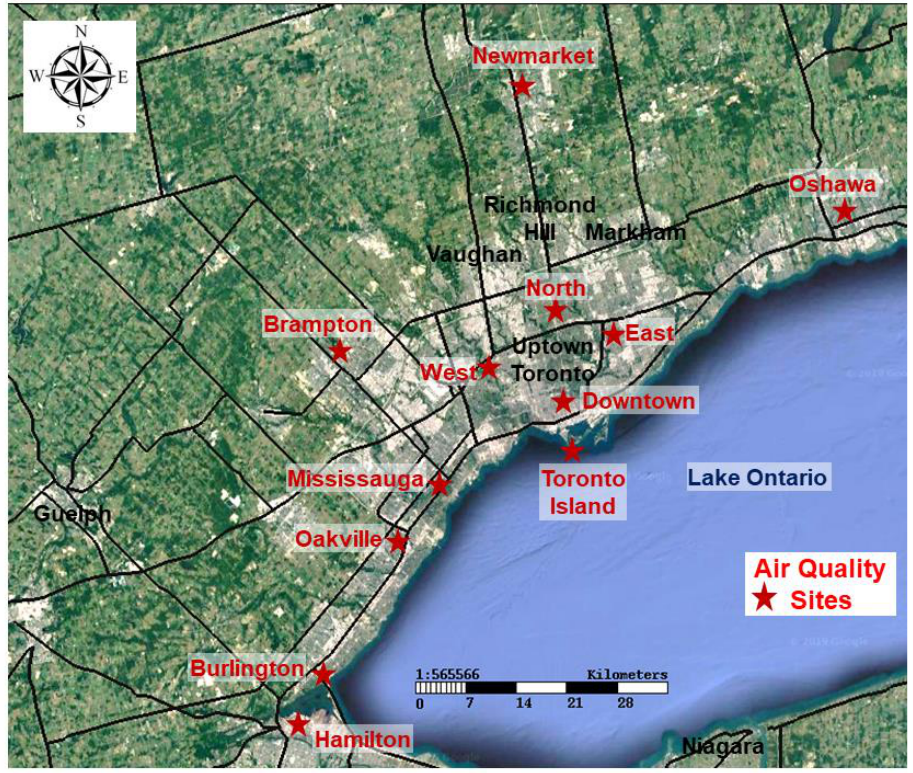
Figure 2. Air quality measurement sites in the Greater Toronto Hamilton Area (GTHA). City names are referred to throughout the text. Black lines are major roads. Lake Ontario is one of the Great Lakes located in Eastern North America and separates Canada from the U.S. Background map courtesy of Google